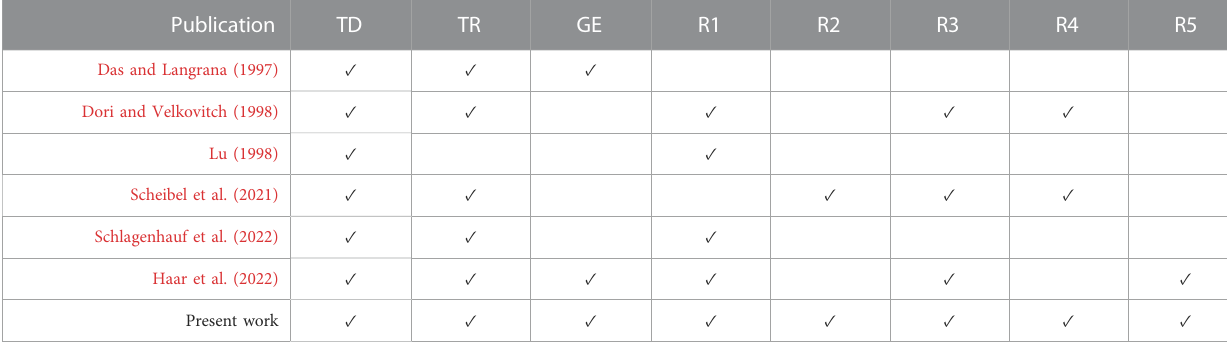
TABLE 1 Summary of contributions to detection and recognition elements on mechanical